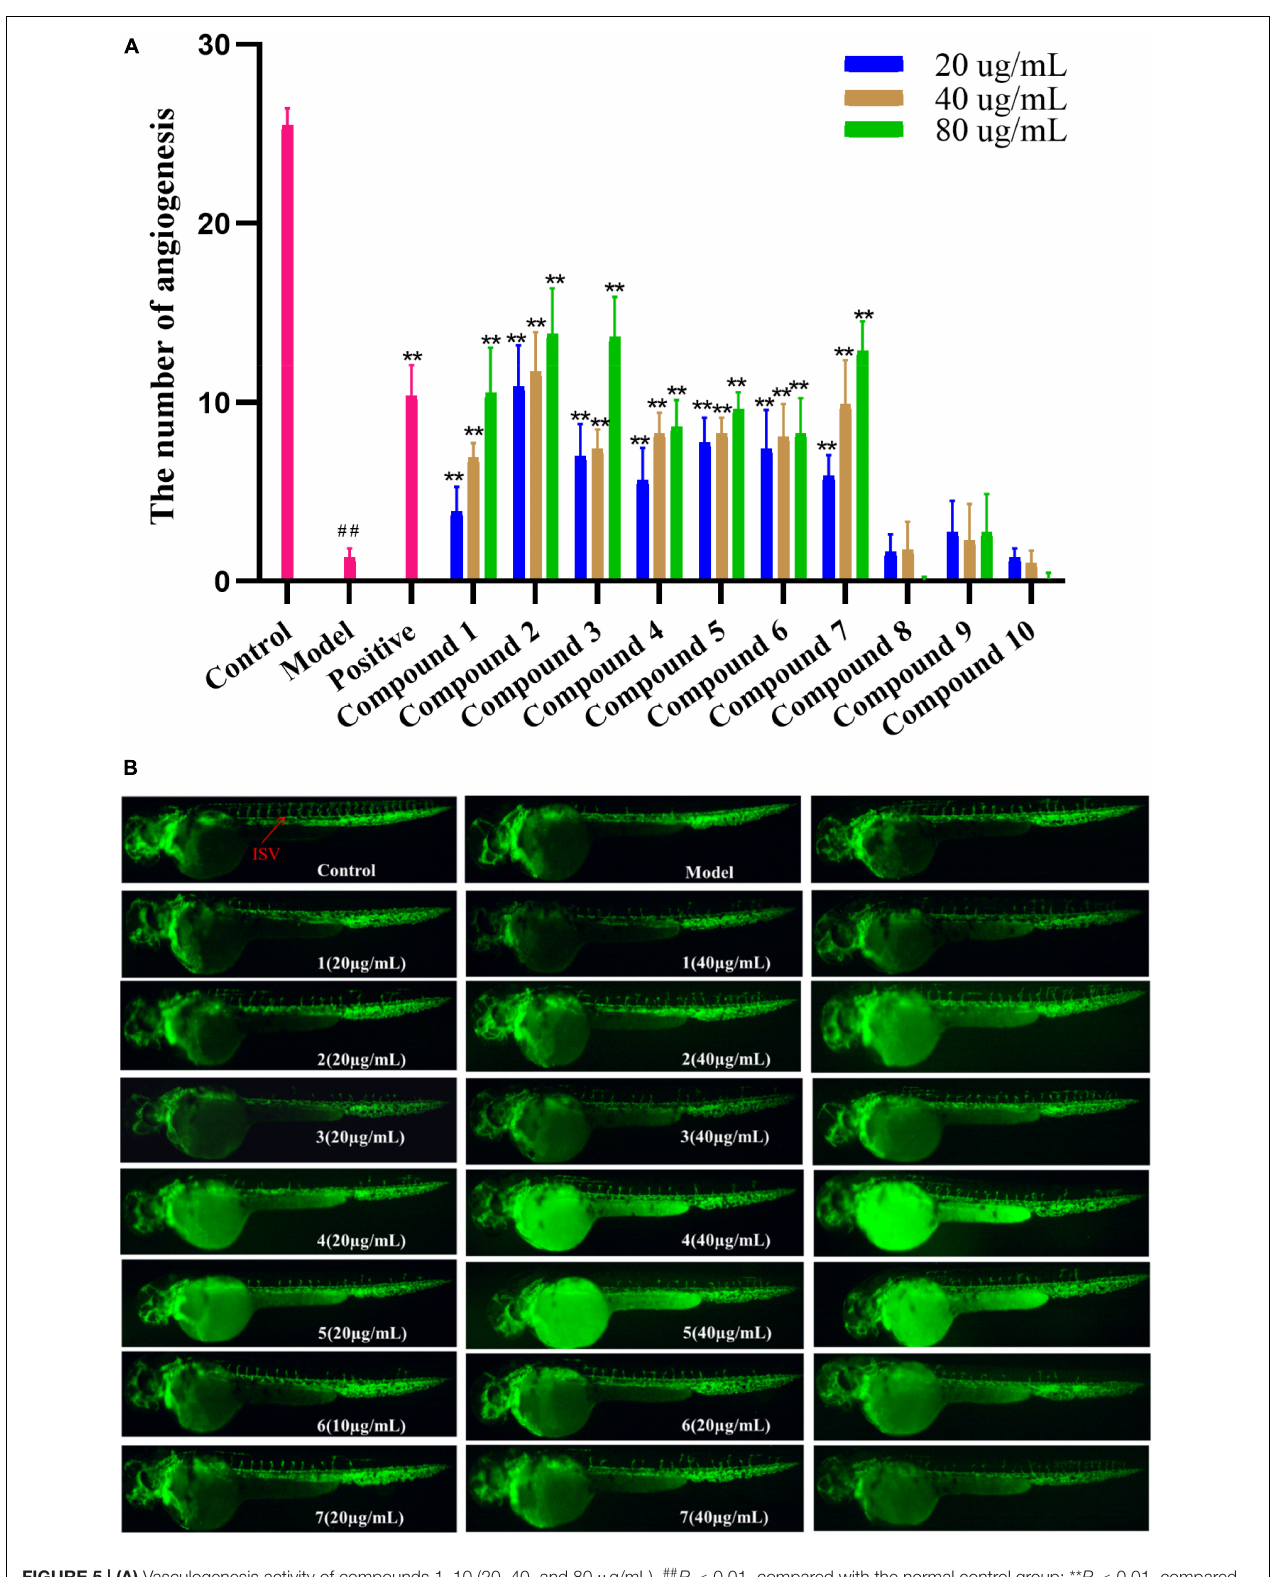
FIGURE 5 | (A) Vasculogenesis activity of compounds 1–10 (20, 40, and 80 µ g/mL). ## P < 0.01, compared with the normal control group; ** P < 0.01, compared with the model control group. (B) Images of intersomitic vessels (ISV) in transgenic fluorescent zebrafish.